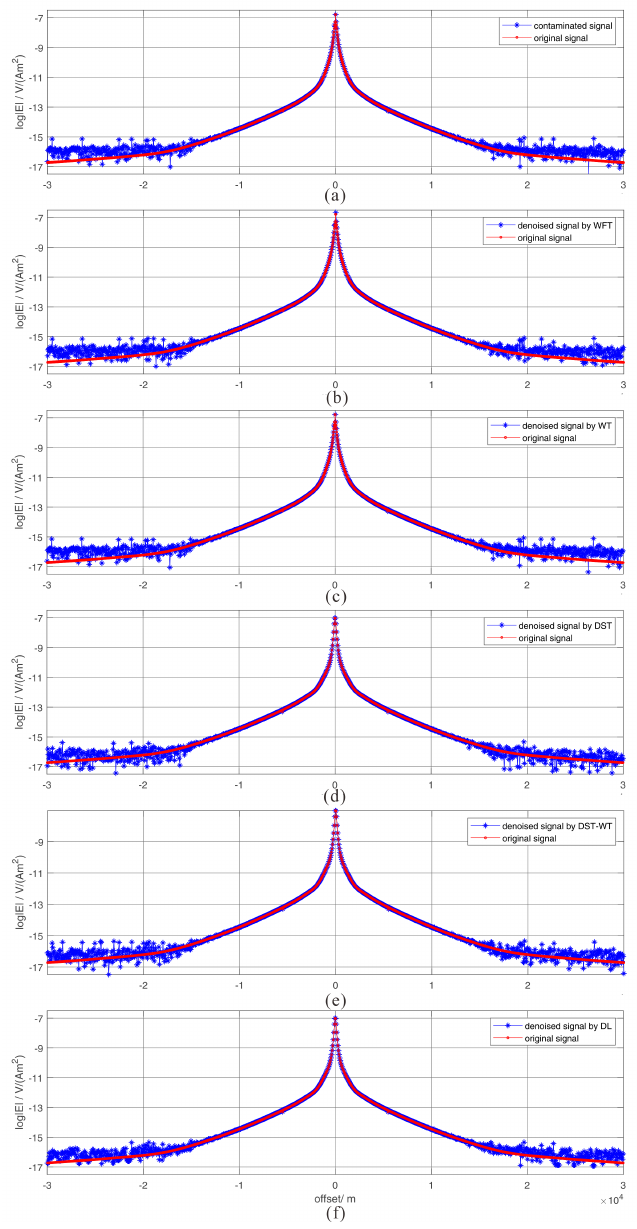
Figure 9. The denoising results of different methods for synthetic data. ( a ) is the comparison MVO plot between original and contaminated signals, ( b ) is the contrast plot between denoising results after WFT (windowed Fourier transform) and the original signal, ( c ) is the comparison MVO plot between denoising results of wavelet transform and the original signal. ( d ) is the contrast plot between denoising results under DST (discrete sine transform) dictionary and the original signal. ( e ) is the comparison MVO plot between denoising result under DST-wt (discrete sine transform and wavelet transform merged dictionary) dictionary and original signal ( f ) is the denoising result under learned